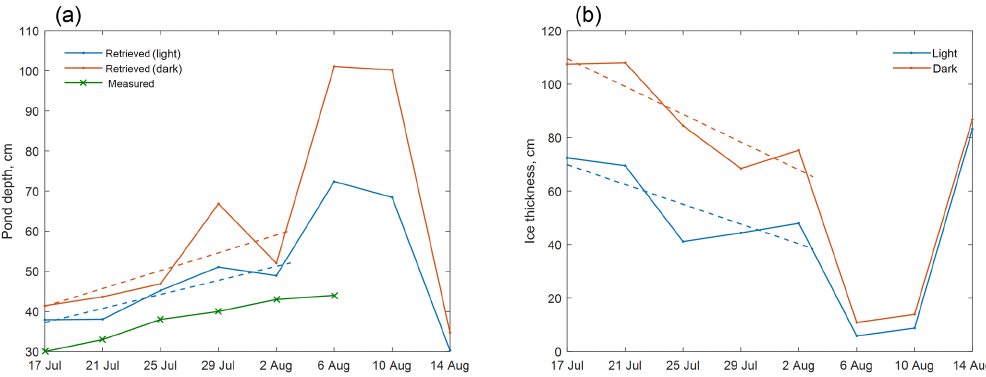
Figure 12. Retrieved pond depth (a) and ice thickness (b) for the two parts of the dual pond shown in Fig. 11. The measured pond depth is shown with crosses. The dashed lines show the linear regression for the first five dates.